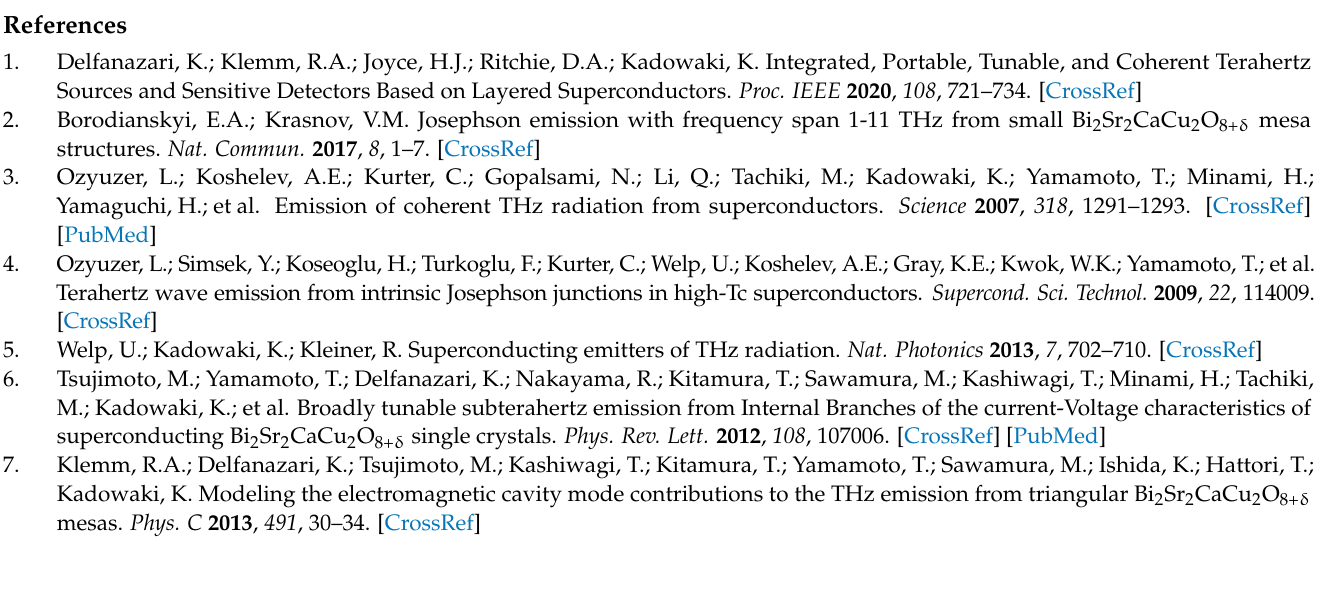
Figure A2. Absorption coefficient of ( a ) BSCCO plasmonic waveguide as a function of temperature at different frequencies. The vertical dashed line shows the T c of BSCCO. ( b ) Gold plasmonic waveguide as a function of frequency. The absorption coefficient of the gold waveguide is temperature- independent.